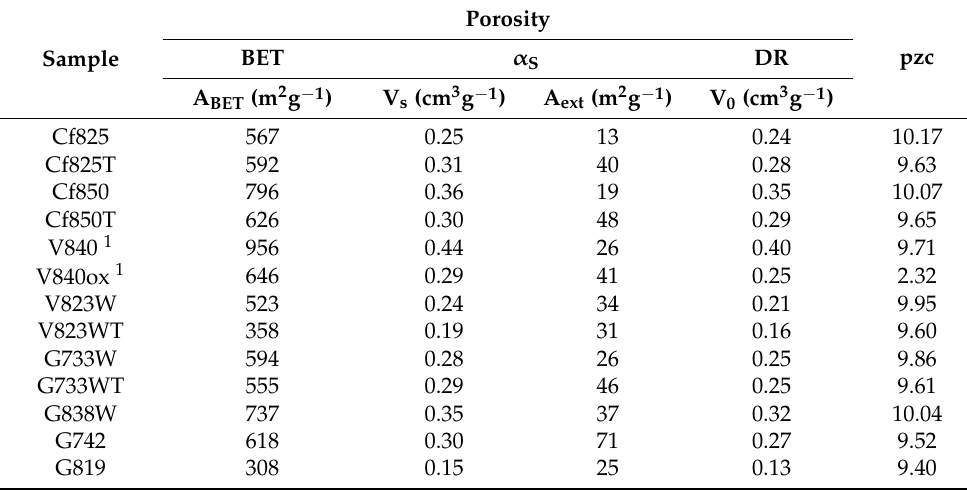
Table 1. Textural and chemical characterisations of the activated